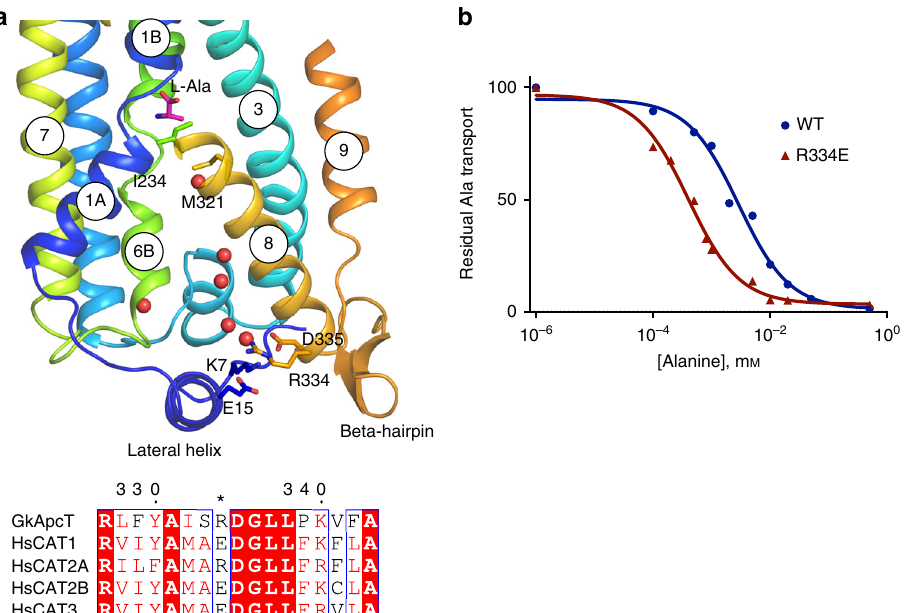
Fig. 5 Structural basis for isoform difference between CAT-2A and -2B. a Zoomed-in view of the cytoplasmic region of the transporter, highlighting the interactions between TM6B, TM8 and the lateral helix. A sequence alignment of TM8 highlighting the difference (*) between CAT-2A and CAT-1, -2B and -3 is shown. b Representative IC 50 curves determined for L -Ala binding to either the WT or R334E variant of GkApcT using electrogenic accumulation assays. IC 50 values were calculated from three independent